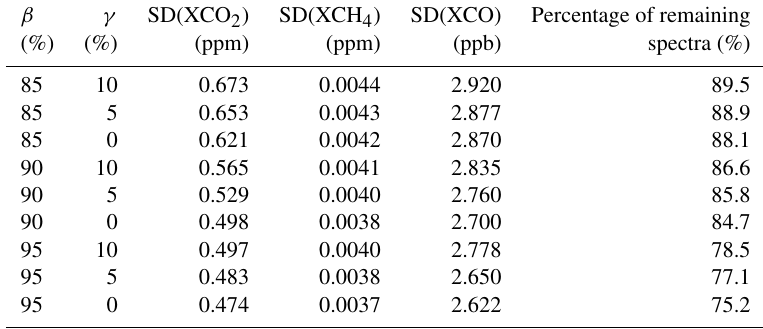
Table 1. The SD of XCO 2 , XCH 4 and XCO of the remaining data after each solar intensity (SI) filtering for each day and the percentage of the remaining number of spectra from 14 June to 31 December 2018. Only measurements recorded within the ± 1h window around local noon are considered. β